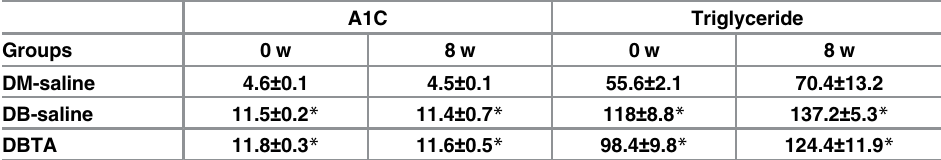
Table 3. Effect of tadalafil on A1C and